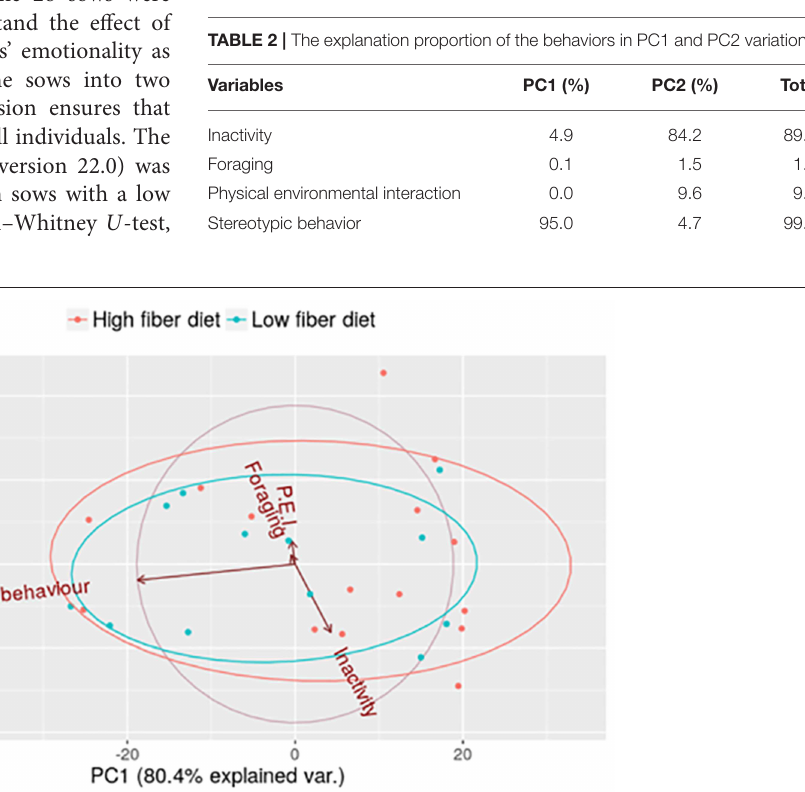
Frontiers in Veterinary Science |